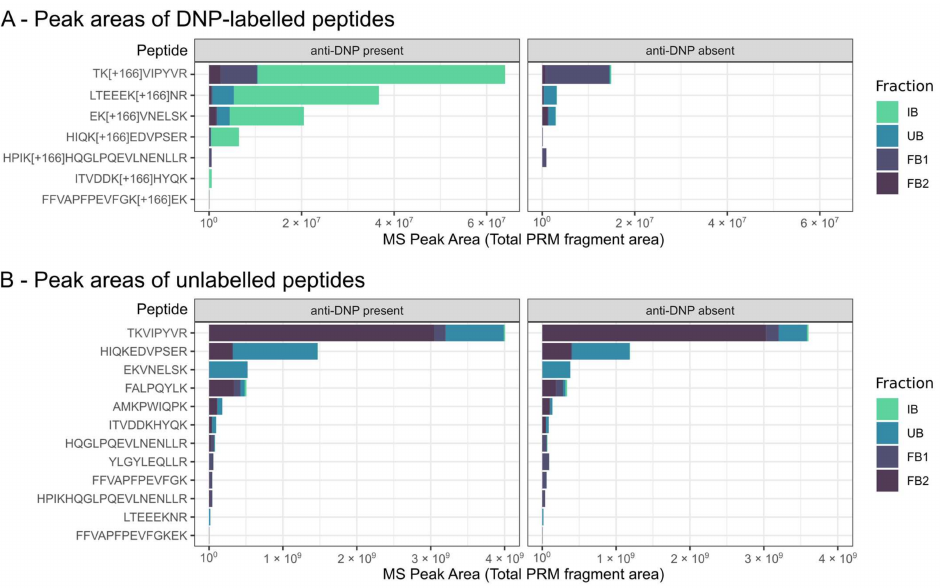
Figure 2. Bar chart of peak abundances of DNP-labeled peptides ( A ) and unlabeled peptides ( B ). The peptides were determined in the presence (left) or the absence (right) of anti-DNP. Color of the bars indicate corresponding fractions: IgG-bound fraction (IB), unbound fraction (UB), fraction remaining in the filter (FB1) and passed the MW filter (FB2) after acidification and